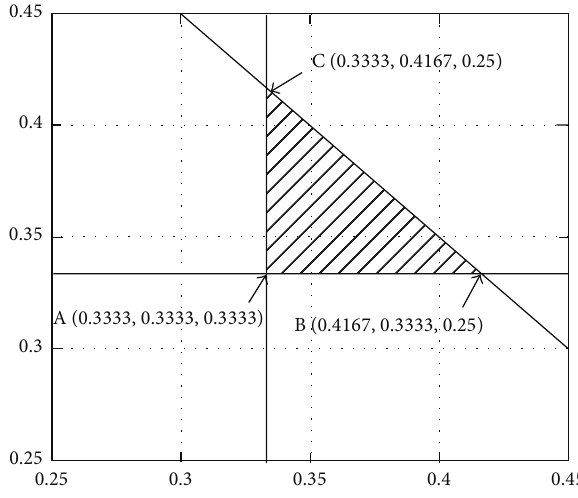
Figure 1: The admissible region 𝛼 1 and 𝛼 2 ( 𝑥 label: 𝛼 1 , 𝑦 label: 𝛼 2 and 𝛼 1 + 𝛼 2 + 𝛼 3 = 1